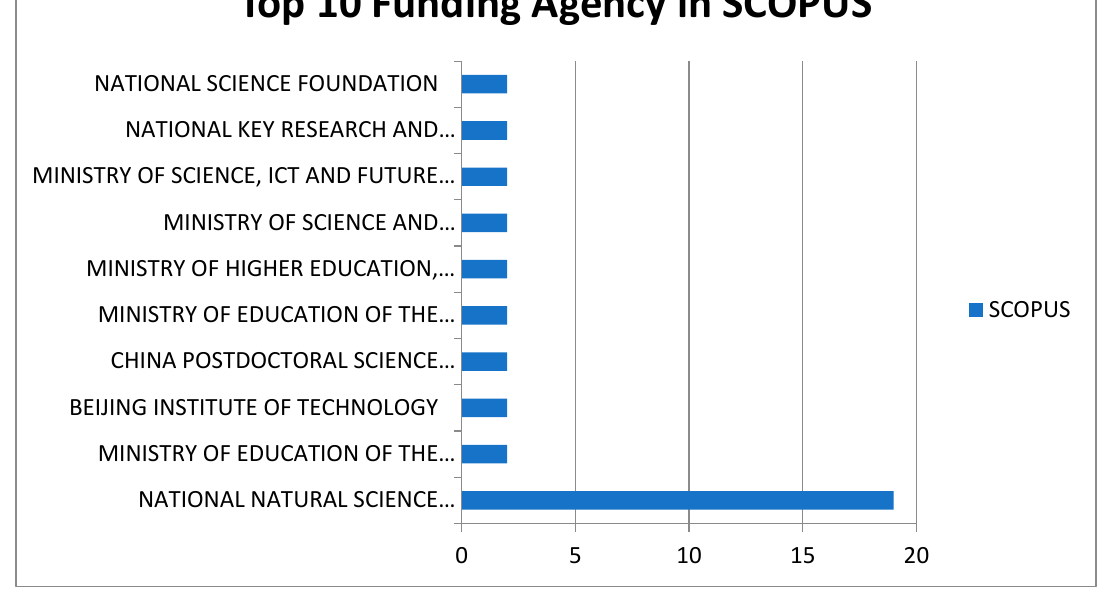
Figure 8. Top ten funding agencies in BMS EV for SCOPUS DB.